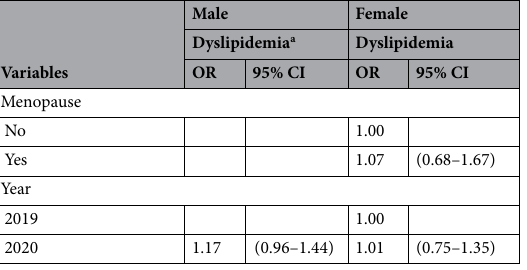
Table 2. Association between Dyslipidemia and subject demographic. BMI body mass index. a One of the